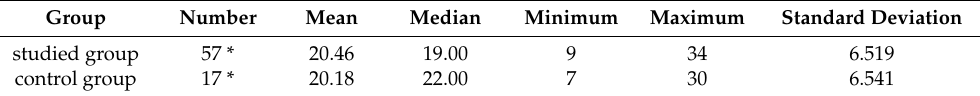
Table 1. Descriptive statistics for PSS-10 values for studied and control group.